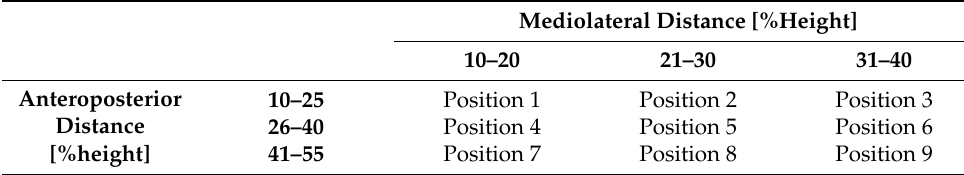
Figure 2. Assistive motion for sit-to-stand with different foot positions. Table 1. Foot distances of the nine foot positions during manual